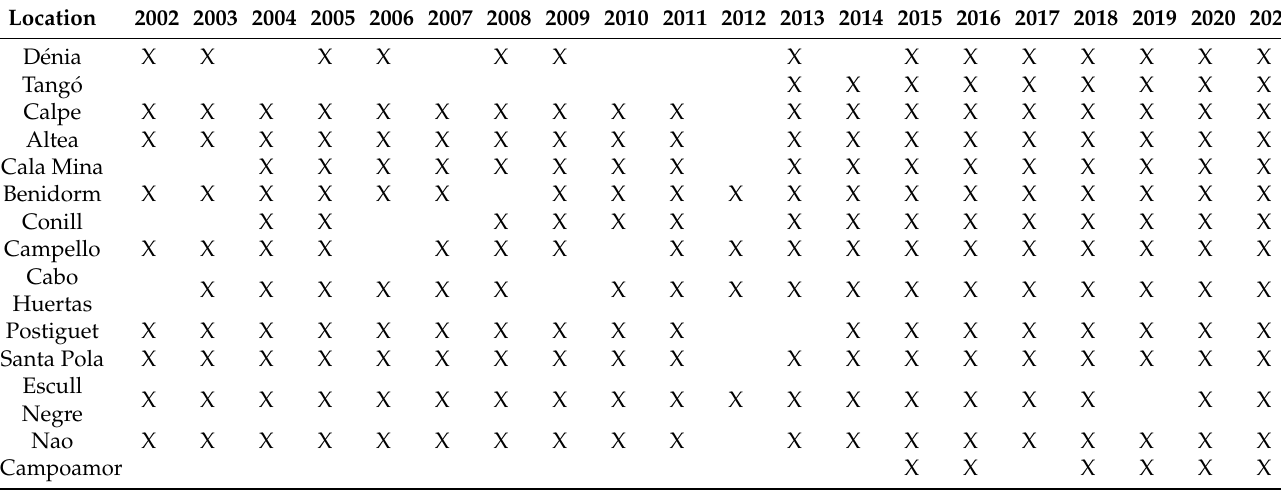
Figure 1. Map of the coast of Alicante province (eastern Spain) with 14 sampling stations. Table 1. Stations and years where the monitoring took place.